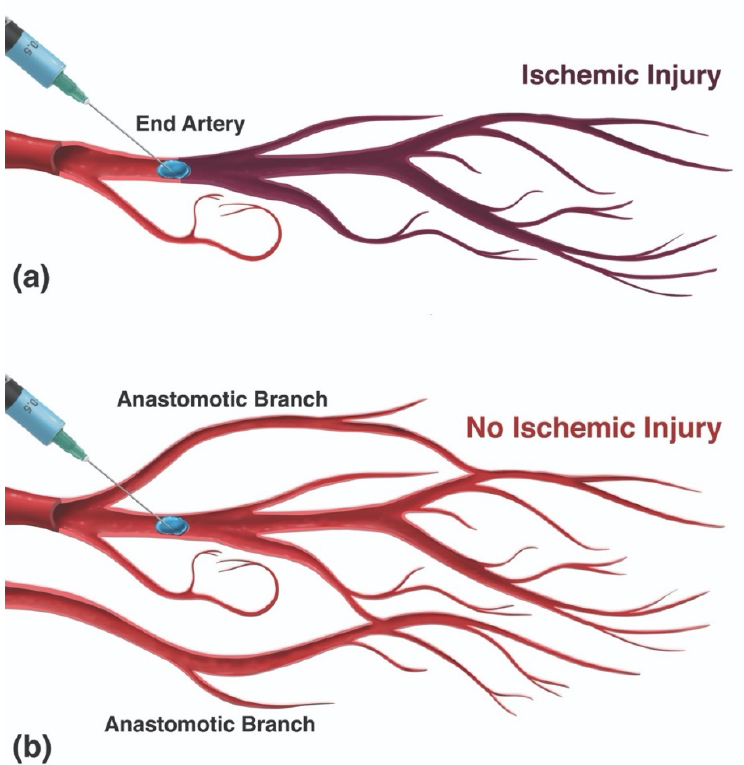
Figure 11. Influence of the configuration of a vascular network on the likelihood of tissue underperfusion/ischemia with a type II dissemination pattern. ( a ) In an end-arterial configuration, such as that seen with the retinal arterial system, a proximally obstructive plug can result in a significant decrease in tissue perfusion and a higher likelihood of ischemia. ( b ) In the presence of collateral perfusion supplied by anastomotic branches, a proximal plug is not likely to result in significant underperfusion or ischemia.